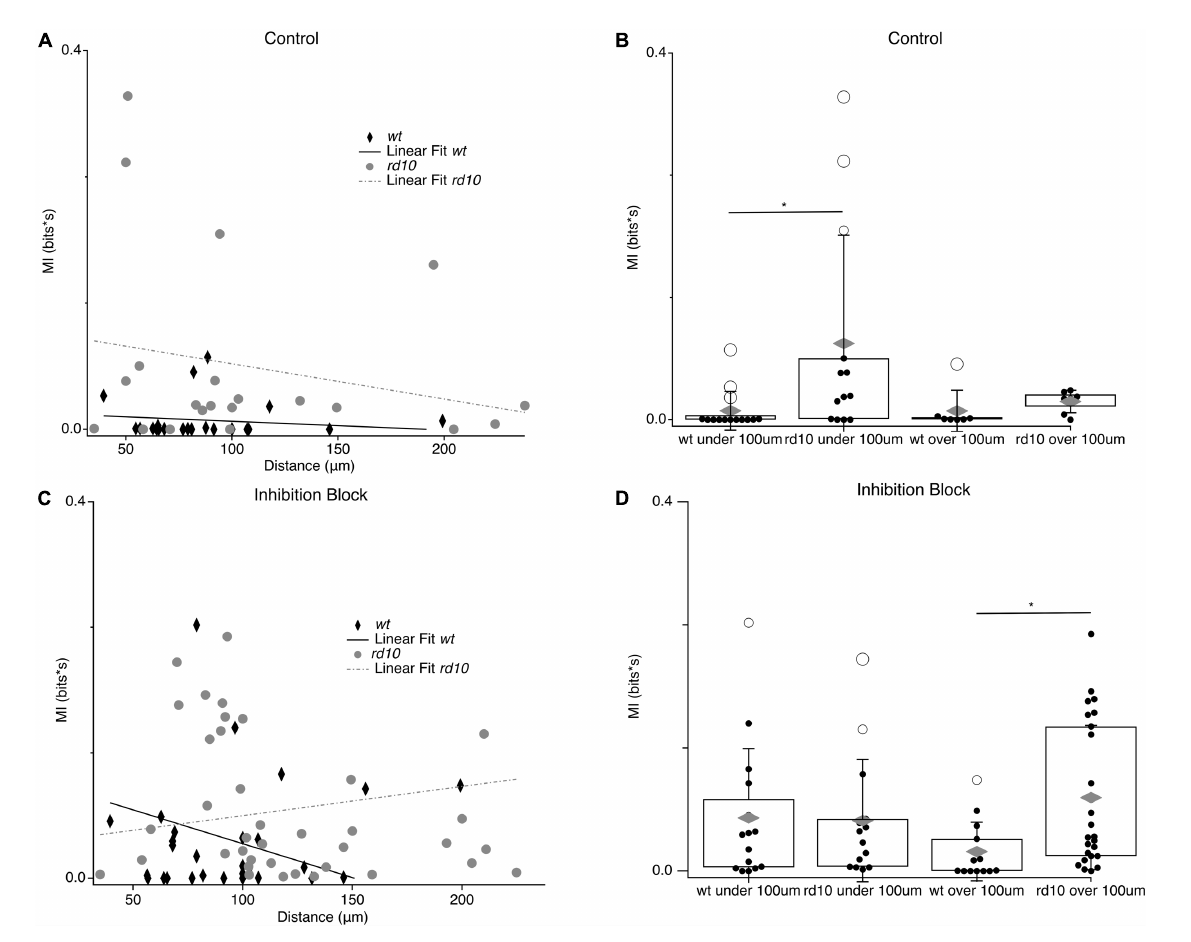
FIGURE8 Relationship between MI and inter-pair distance. (A) Scatter plots for wt (black diamonds) and rd10 (grey circles) RGC pair spontaneous MI time plotted against inter-pair distance. Solid black line and broken grey line shows the linear fit for wt and rd10 , respectively. (B) Binned spontaneous MI under 100 µ m and over 100 µ m in control conditions for both wt and rd10 . Filled black circles represent data points, open circles represent outliers, whiskers show 1 standard deviation, gray diamonds represent the mean. (C,D) Same as (A,B) but for in inhibition block (5 µ M SR-95531, 50 µ M TPMPA, and 5 µ M strychnine). *Denotes p <